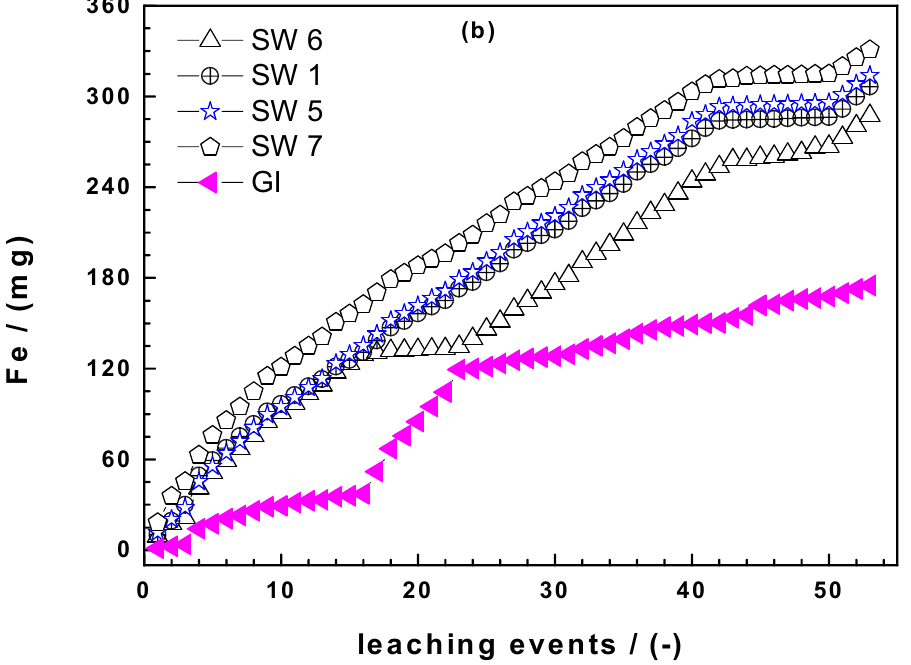
Figure 4. Comparison of the extent of iron dissolution in column leaching experiments for SW1, SW5, SW6, SW7, and GI: ( a ) Iron concentration and ( b ) cumulative mass of dissolved iron. Experimental conditions: m iron = 0.500 g, [EDTA] = 2 mM.